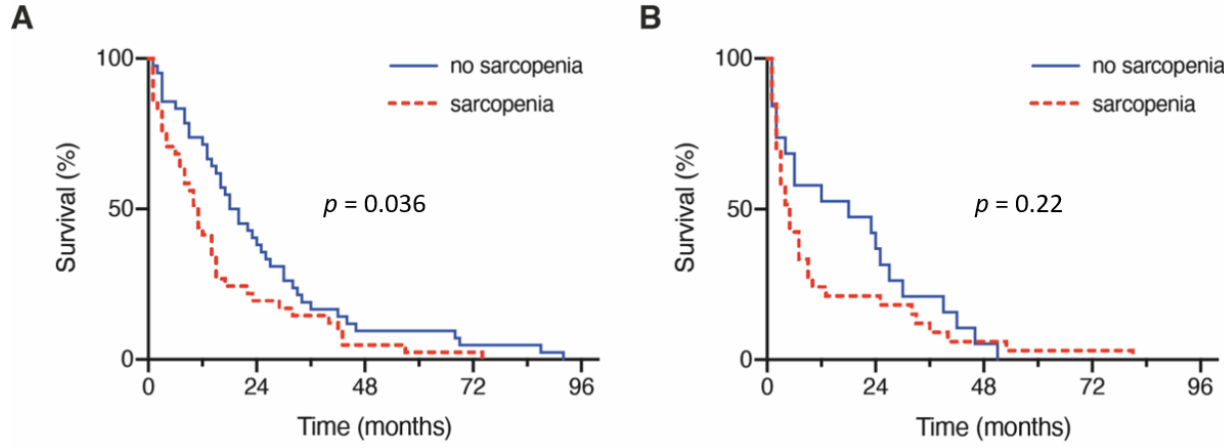
Figure 3. Patient sarcopenia correlations to OS rates stratified for ( A ) patients aged < 65 y and ( B ) patients ≥ 65 y. y, years.